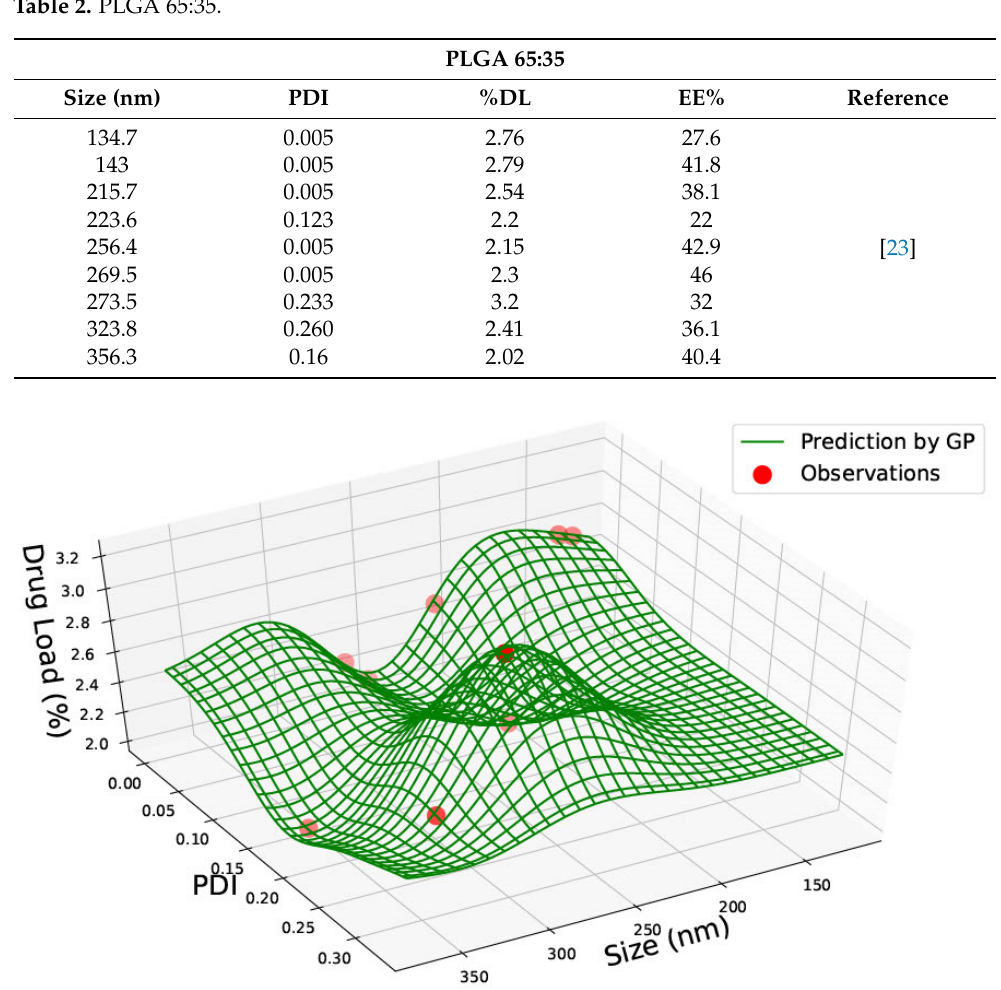
Table 2. PLGA 65:35.